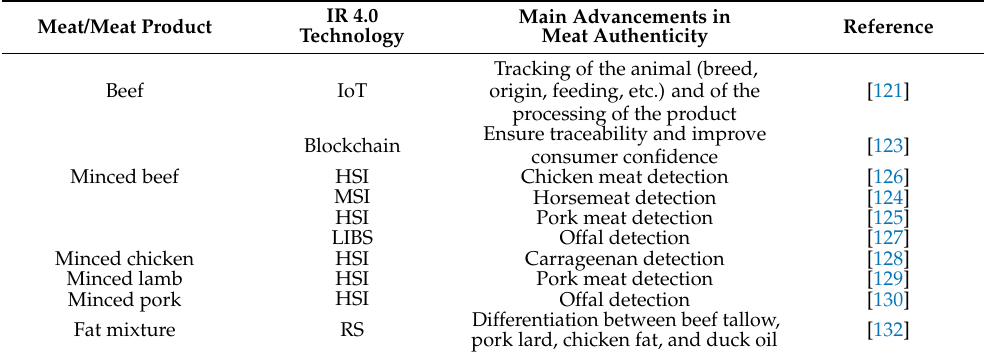
Table 4. Applications and possible applications of IR 4.0 technologies for meat authenticity. Meat/Meat